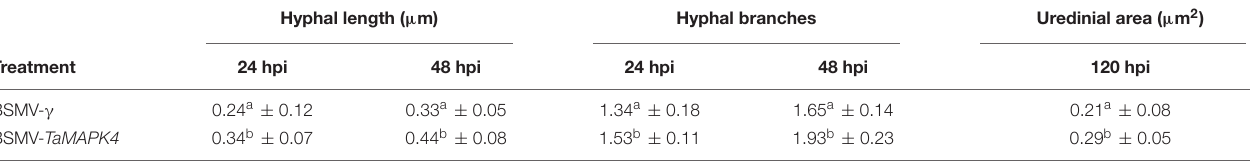
TABLE 1 | Histological analysis of TaMAPK4 knockdown leaves responding to infection by Pst race 23. Hyphal length ( µ m)